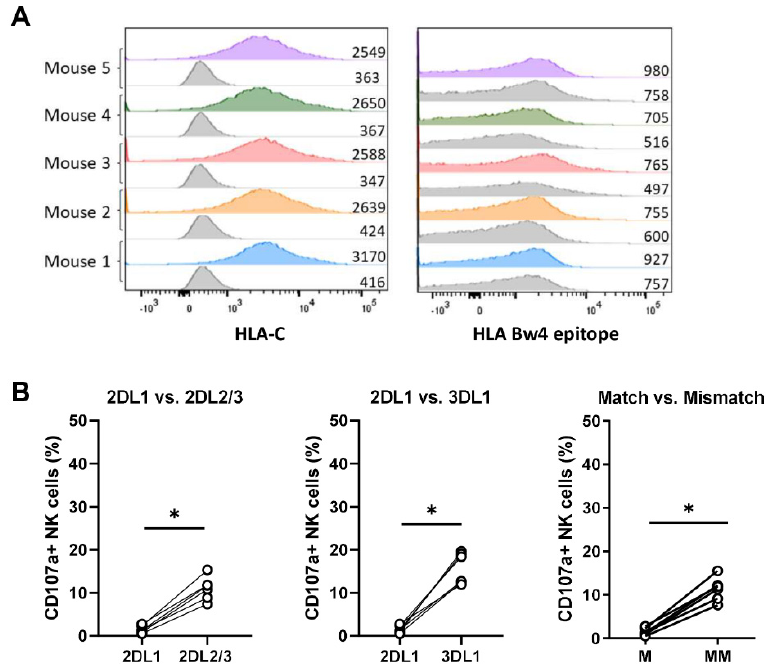
Figure 5. NK cell degranulation of KIR-ligand-matched and -mismatched NK cells in response to MCF7 grown in vivo. MCF7 tumors that were grown in mice were harvested and dissociated into single-cell suspension before performing HLA staining with n = 5 tumors ( A ) or 4 h CD107a assays with n = 6 tumors ( B ). Within the CD107a assay, degranulation is shown for each receptor (left and middle graph) and also as KIR-ligand-matched (M, 2DL1) vs. -mismatched (MM, 2DL2/3 and 3DL1) NK cell subsets as % CD107a + NK cells. Each dot represents a tumor isolated from one mouse and the average of duplicates is depicted. * p < 0.05.